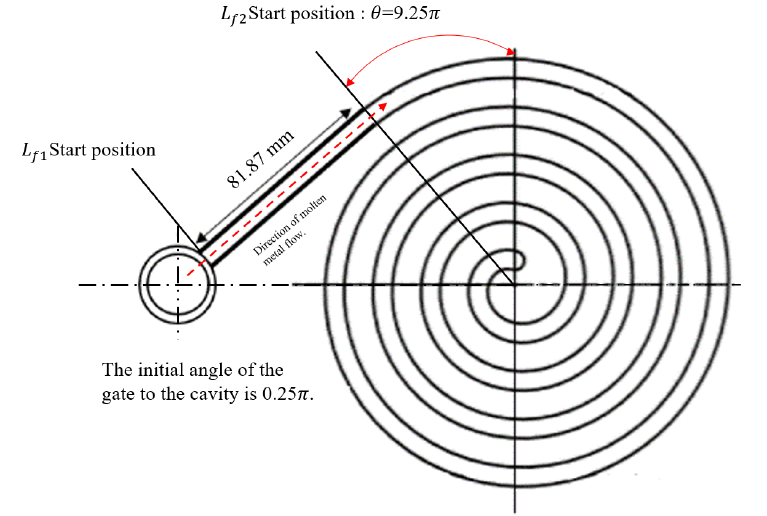
Figure 1. Schematic diagram of spiral